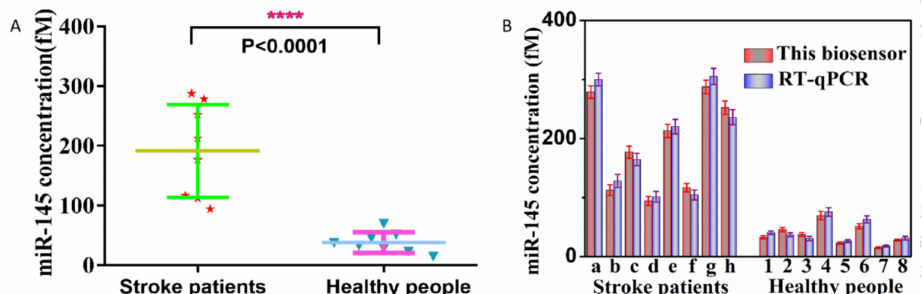
Figure 4. ( A ) The electrochemical biosensor for the detection of miR-145 in stroke patients and healthy people (**** p < 0.0001). ( B ) miR-145 from stroke patients and healthy people was detected by the electrochemical biosensor and RT-qPCR, respectively (error bars: SD, n =